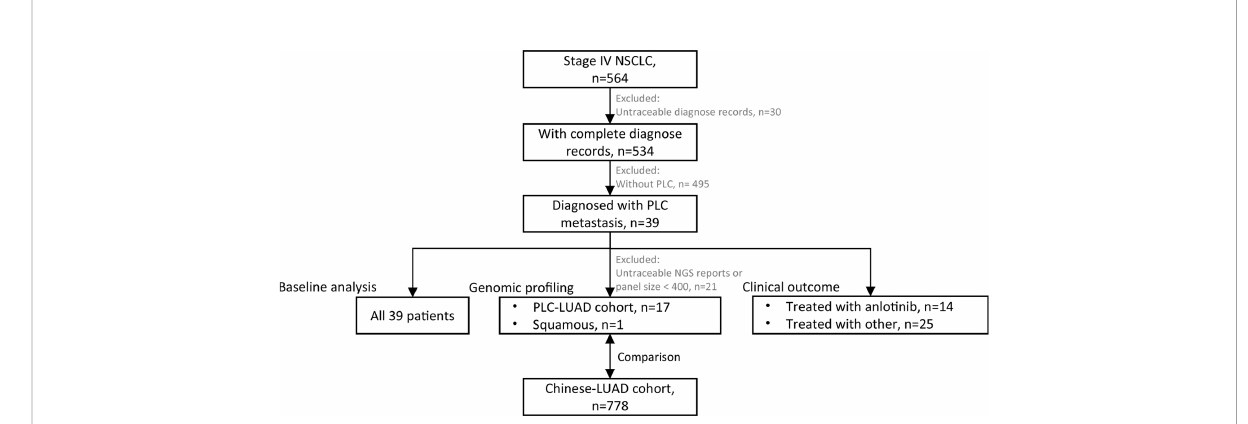
FIGURE 1 Flowchart of patient selection. 39 patients were enrolled for baseline analysis; 18 patients (17 of PLC-LUAD cohort, 1 squamous) with traceable DNA-based next generation sequencing (NGS, panel size > 400 genes) reports were enrolled for genomic pro fi ling, and that of PLC-LUAD was compared to lung adenocarcinoma in Chinese population (Chinese-LUAD cohort); 14 patients treated with anlotinib and 25 with other treatment strategies were enrolled for clinical outcome